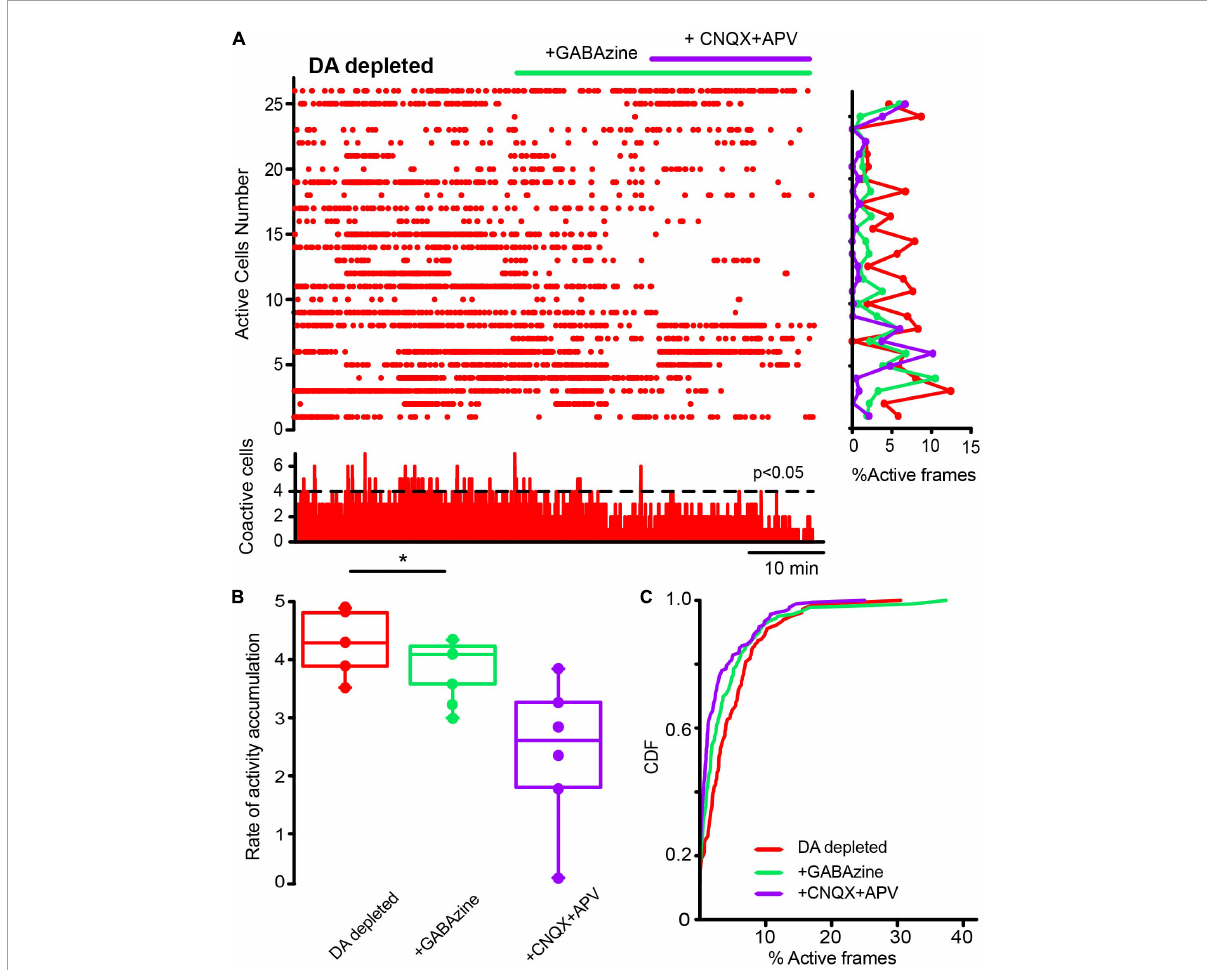
FIGURE10 Inhibitory GABAergic inputs also contribute to cholinergic interneurons hyperactivity in dopamine-depleted tissue. (A) The raster plot represents the activity of identified CINs recorded simultaneously in a DA-depleted striatal slice. Applying 10 µ M of GABAzine decreased hyperactivity contrary to control tissue (cf. Figure 9 ), where inhibition blockade increases neuronal activity as expected. In DA-depleted tissue, activity decreases cell by cell (rows in the histogram at right) and in significant peaks of coactivity (histogram at the bottom). An addition of 10 µ M CNQX and 50 µ M APV appears to further decrease this activity as excitation blockade is expected to do. (B) Box plots show that the rate of activity accumulation is significantly decreased by GABAzine (* P = 0.03; Wilcoxon T). (C) CDFs before and after addition of synaptic antagonists on CINs hyperactivity after DA depletion: DA-depleted CINs vs. CINs with addition of GABAzine: P = 0.0013; plus, addition of CNQX + APV: P < 0.0001; CINs + GABAzine vs. CINs with further addition of CNQX + APV: P = 0.0029 (n-DA depleted-CINs = 163 neurons; + GABAzine = 155 neurons; + CNQX + APV = 149 neurons from n = 6 slices from 6 different animals; Kolmogorov-Smirnov